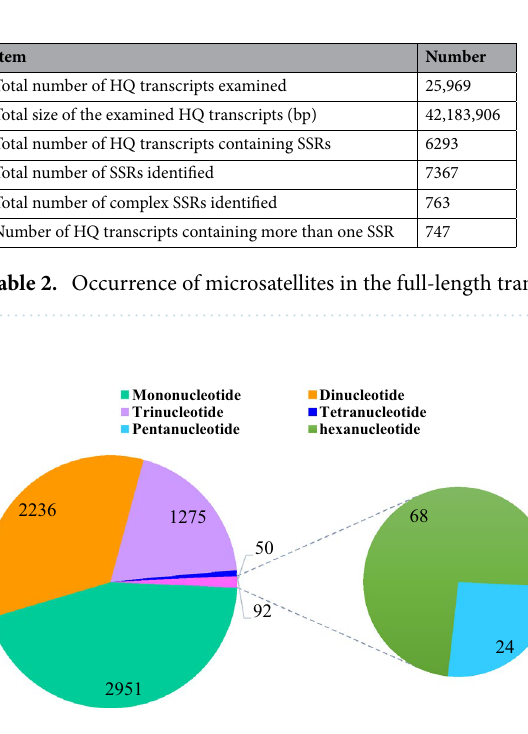
Figure 5. The types and numbers of complete SSRs in P. catalpifolia. Figure was made by Microsoft Office Excel 2013